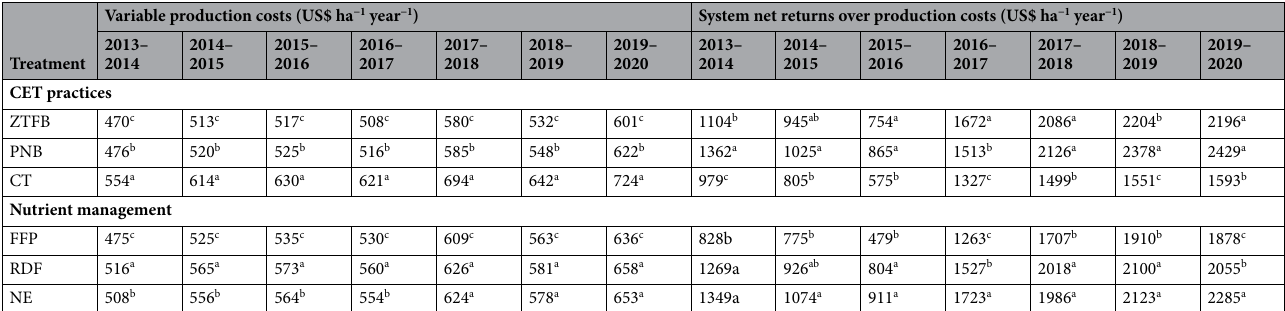
Table 3. Economics of the maize–chickpea rotation under the CA-based CEP and nutrient management during the 7 years of the study. Means followed by a similar uppercase letter within a column is not significantly different ( p < 0.05) according to Tukey’s HSD test. Price of one US $ = 62.9 INR2013–2014; 60.9 INR2014–2015; 64.2 INR2015–2016; 68 INR2016–2017; 64 INR2017–2018; 74 INR2018–2019; 70 INR2019–